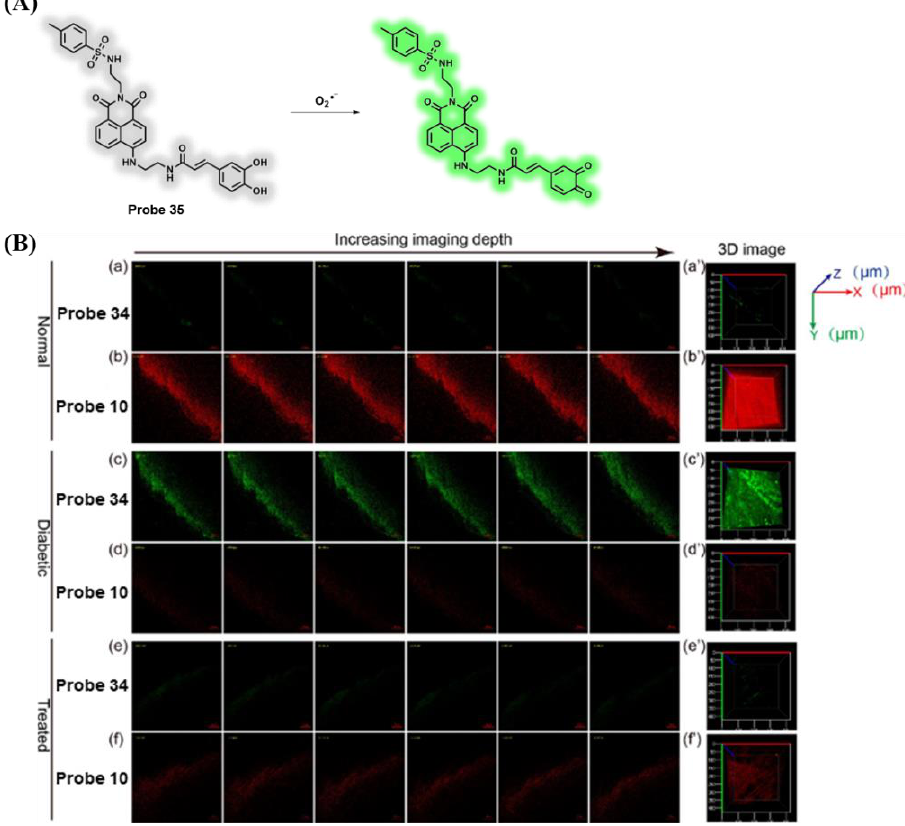
Figure 29. ( A ) Imaging mechanism of probe 34 ; ( B ) confocal fluorescence imaging of endogenous O 2 • – and polarity in myocardial tissues; ( Ba , Bb ) the selected fluorescence images of normal myocardial tissue; ( Bc , Bd ) the selected fluorescence images of diabetic myocardial tissue; ( Be , Bf ) the selected fluorescence images of Metf-treated diabetic myocardial tissue. ( B - a ′ − B - f′ ) The 3D stack images of corresponding myocardial tissue. Conditions: for probe 34 , λ ex = 800 nm, λ em = 500 − 600 nm; for probe 10 , λ ex = 633 nm, λ em = 700 −750 nm. Scale bar: 50 μm. Adapted from Reference [137].